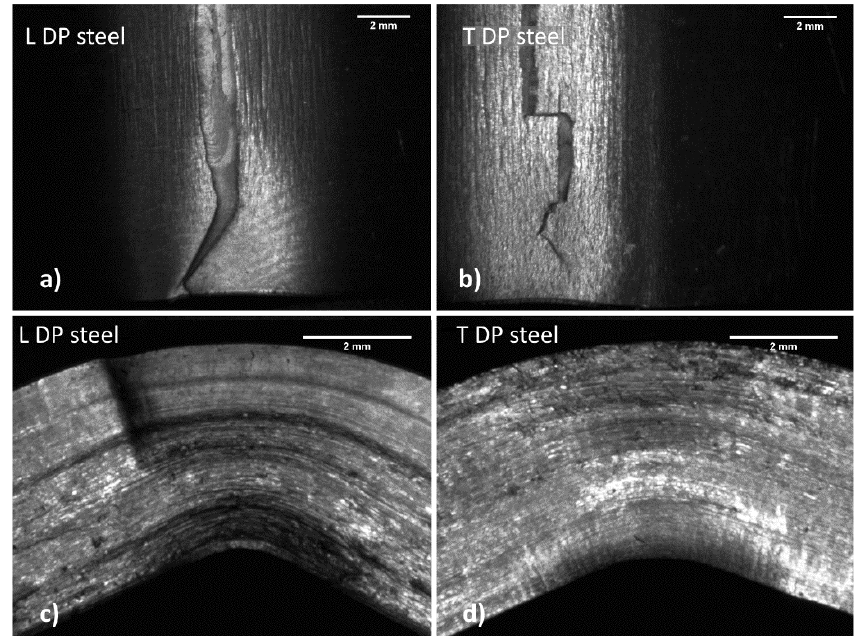
Figure 10. Both longitudinal ( a , c ) and transversal ( b , d ) DP steel samples show a small crack that travels into the resisting section with difficulty.